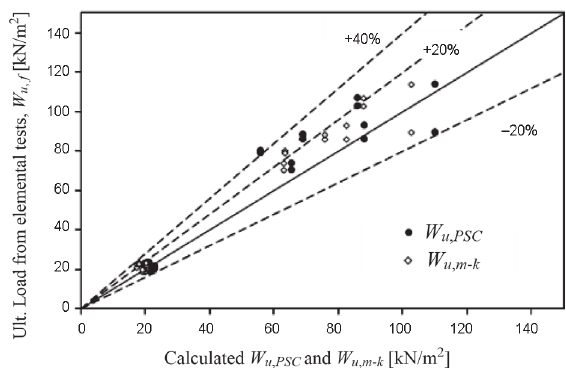
Fig. 12. Comparison of ultimate loads produced from the full size tests and the calculated loads, using the improved PSC and m-k methods (data from Table 5)